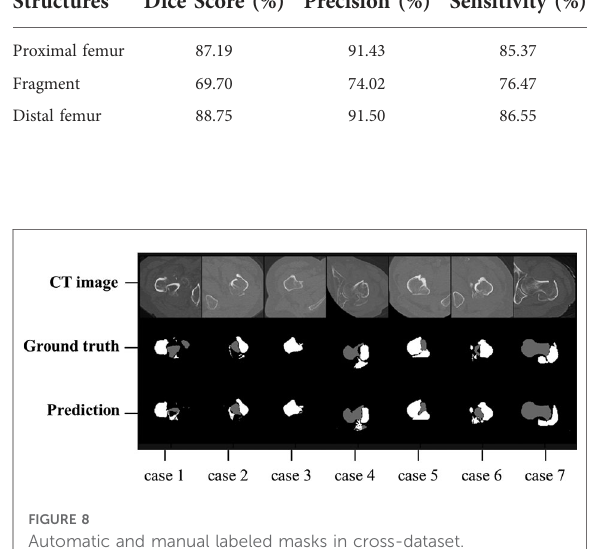
(41.29 ∼ 56.59 mm), and that of the manual segmentation group was 45.9 ± 6.1 mm (40.34 ∼ 64.93 mm). The mean absolute error (MAE) of FHD in the automatic segmentation group and manual segmentation group were 3.38 mm and 3.52 mm,